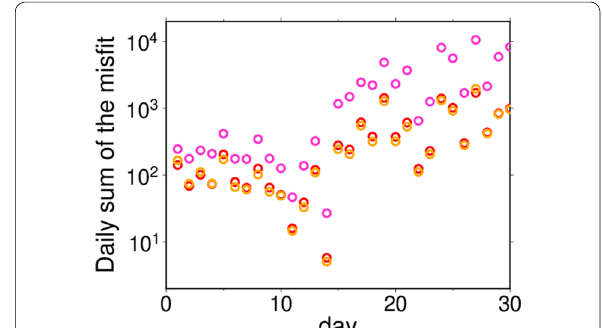
Fig. 12 Daily misfit values. Misfit between the theoretical and the observed time series are daily summed up for all GNSS stations. The theoretical time series are calculated by using the first-guess values (pink circles), the optimum values when only frictional parameters are optimized (red circles), and the optimum values when frictional parameters and initial values are simultaneously optimized (orange circles), respectively